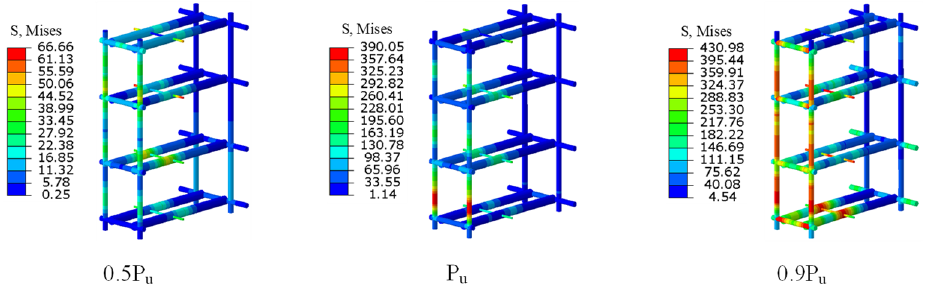
Figure 17. Contour plots of Mises stress for shear connection reinforcement.